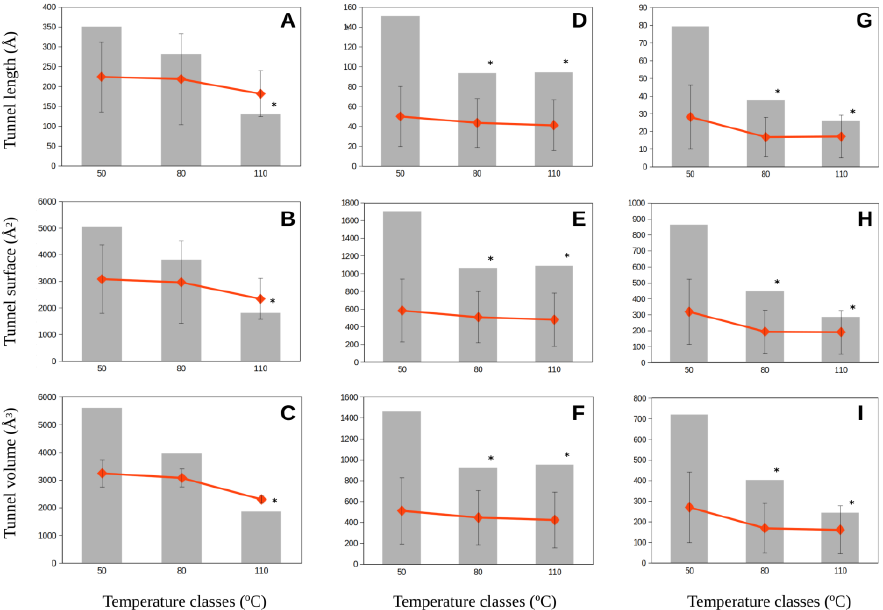
Figure 5. Amplitude and average of the molecular tunnel dimensions, length ( A , D , G ), surface ( B , E , H), and volume ( C , F , I ) (in Å ), predicted for the heterodisulfide reductas (Hdr) subunit genes, A ( A , B , C ), B ( D , E , F ), and C ( G , H , I ) from methanogenic Archaea classified in three classes of optimum growth temperature (<50 °C; 50 – 80 °C; >80 °C). Gray bars correspond to the amplitude of data observed for estimates of the molecular tunnel dimensions. Red squares represent the average dimensions for each growth temperature class. Error bars for the average values represent a standard deviation. Asterisks denote statistical significance ( p < 0.05) with respect to the temperature class < 50 °C.